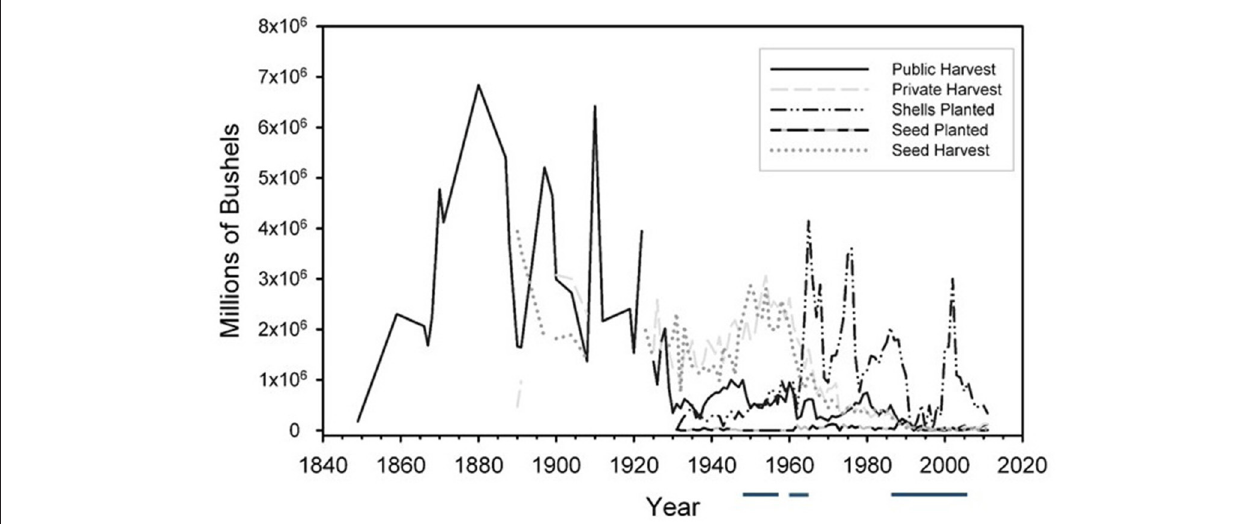
FIGURE 2 | History of the oyster fishery, showing public, private, and seed harvests with repletion activity (shell and seed plants) over time. Data for repletion 2003-14 are based on estimates from VMRC annual work plans. 1 bushel = 0.049225 m 3 . Blue lines are years of disease epidemics, first line is the first Dermo epidemic peak years, second line are the peak years of the MSX epidemic, third line is the second Dermo epidemic peak years.